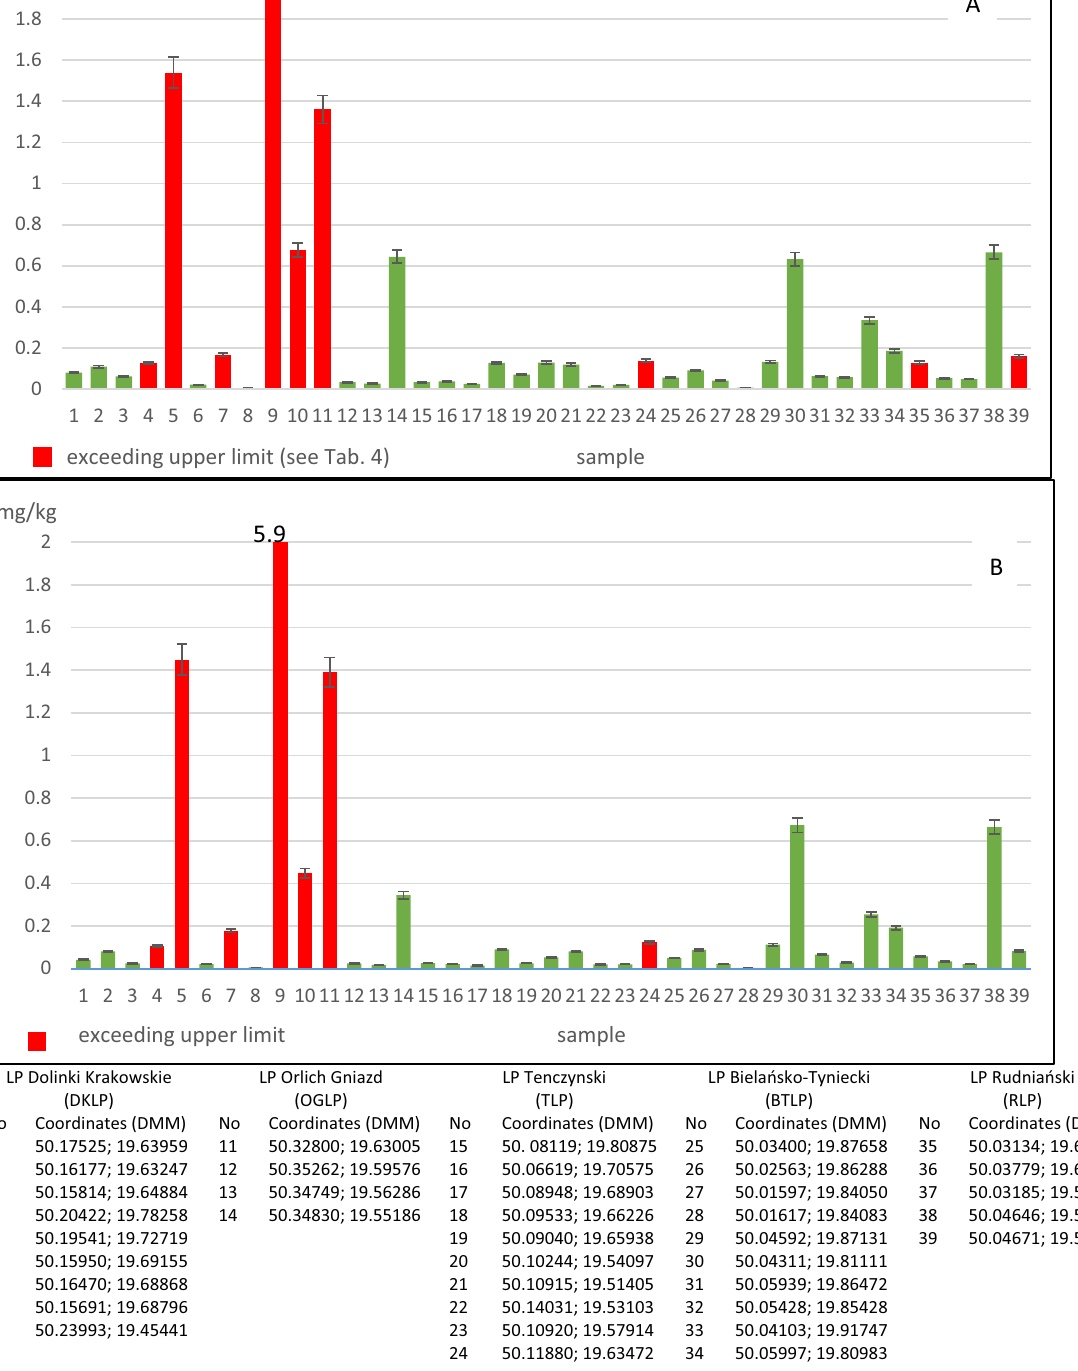
Figure 3. The content of benzo(b)fluoranthene ( A ) and benzo(a)pyrene ( B ) in collected